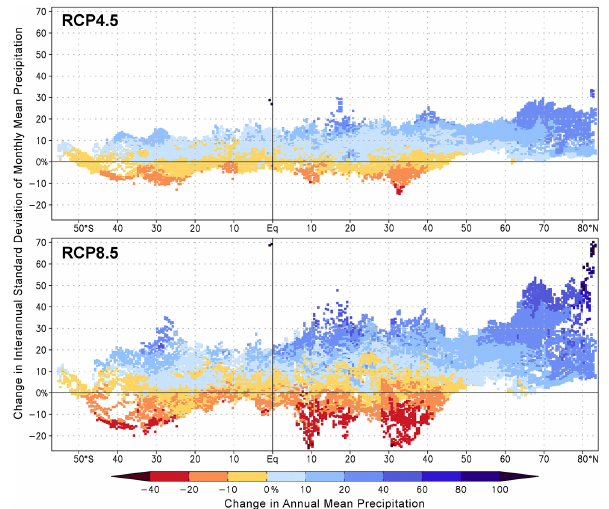
Figure 4. Scatter diagram of the change from the historical case to the indicated future climate projection of the annual mean precipi- tation (color) and average IASD of monthly mean precipitation ( y axis) for all land points as a function of latitude. Each mark is a grid box on the interpolated high-resolution grid. All changes are expressed as a percentage of the climatological value from the his- torical case.